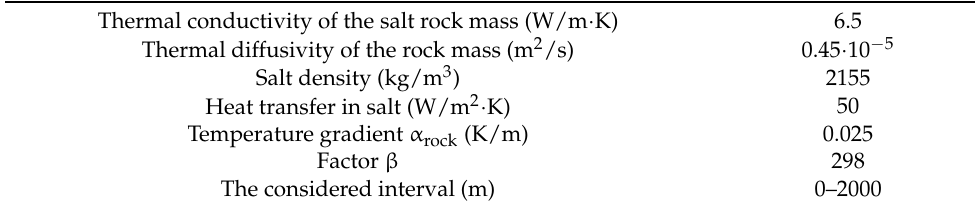
Table 2. Thermal properties of salt adopted in the